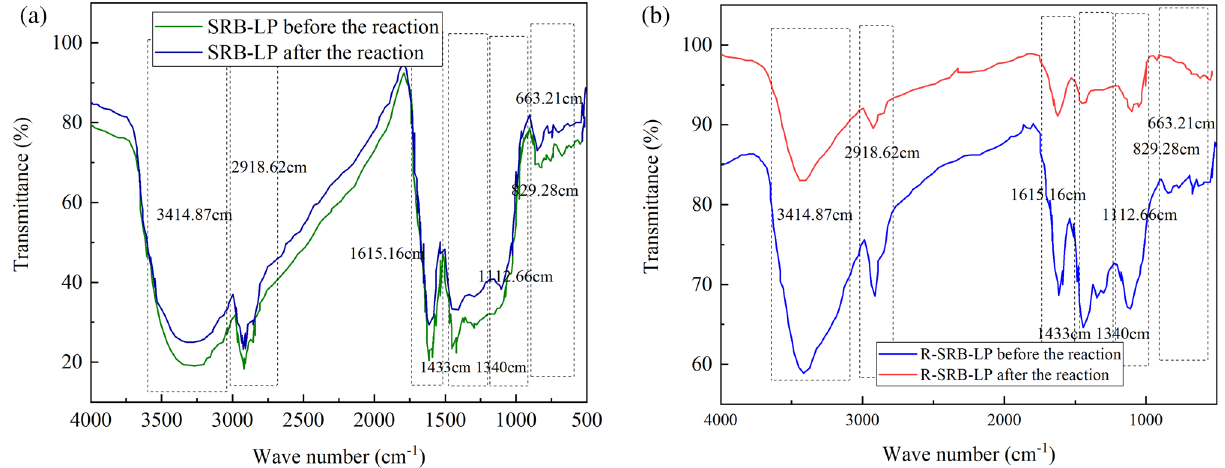
Figure 9. FTIR plots of SRB-LP and R-SRB-LP before and after AMD treatment. ( a ) FTIR of SRB-LP before and after reaction. ( b ) FTIR of SRB-LP before and after